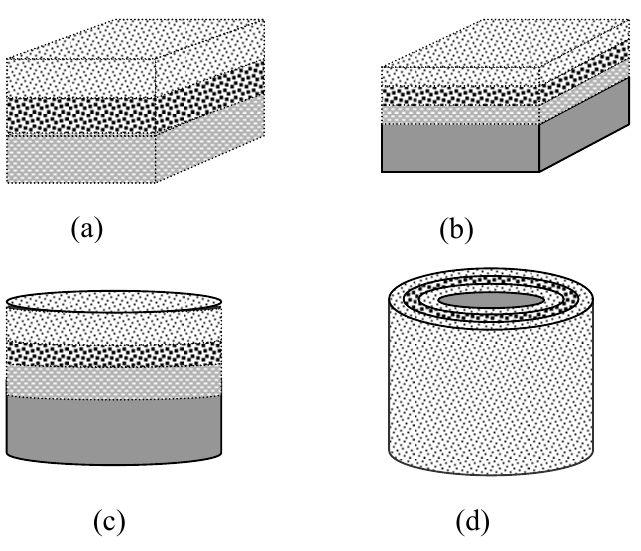
Figure 2. Schematic diagrams showing the basic configurations and shapes of the graded/gradient porous biomaterials: (a) graded porous block; (b) graded porous block with a dense part; (c) graded porous disk with a dense part; (d) graded porous layer on a cylindrical dense